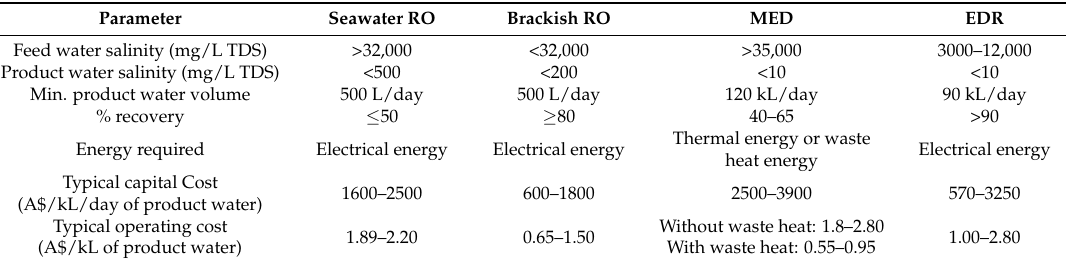
Table 1. Summary of desalination technologies